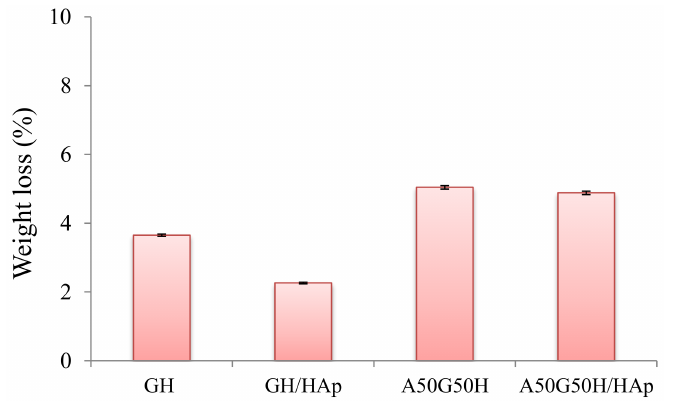
Figure 6. Weight loss during the degradation of hydrogel scaffolds.